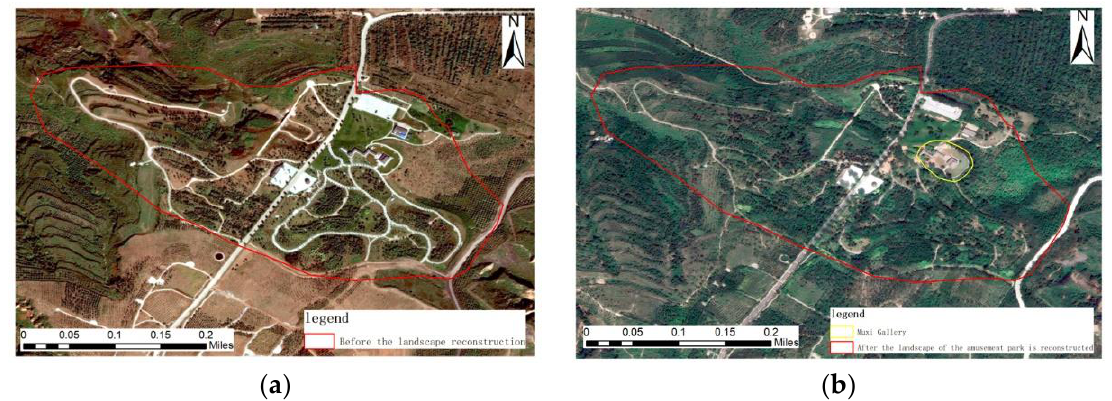
Figure 11. Remote sensing images before and after ecological restoration in the garden landscape reconstruction area. ( a ) before treatment; ( b ) after treatment.